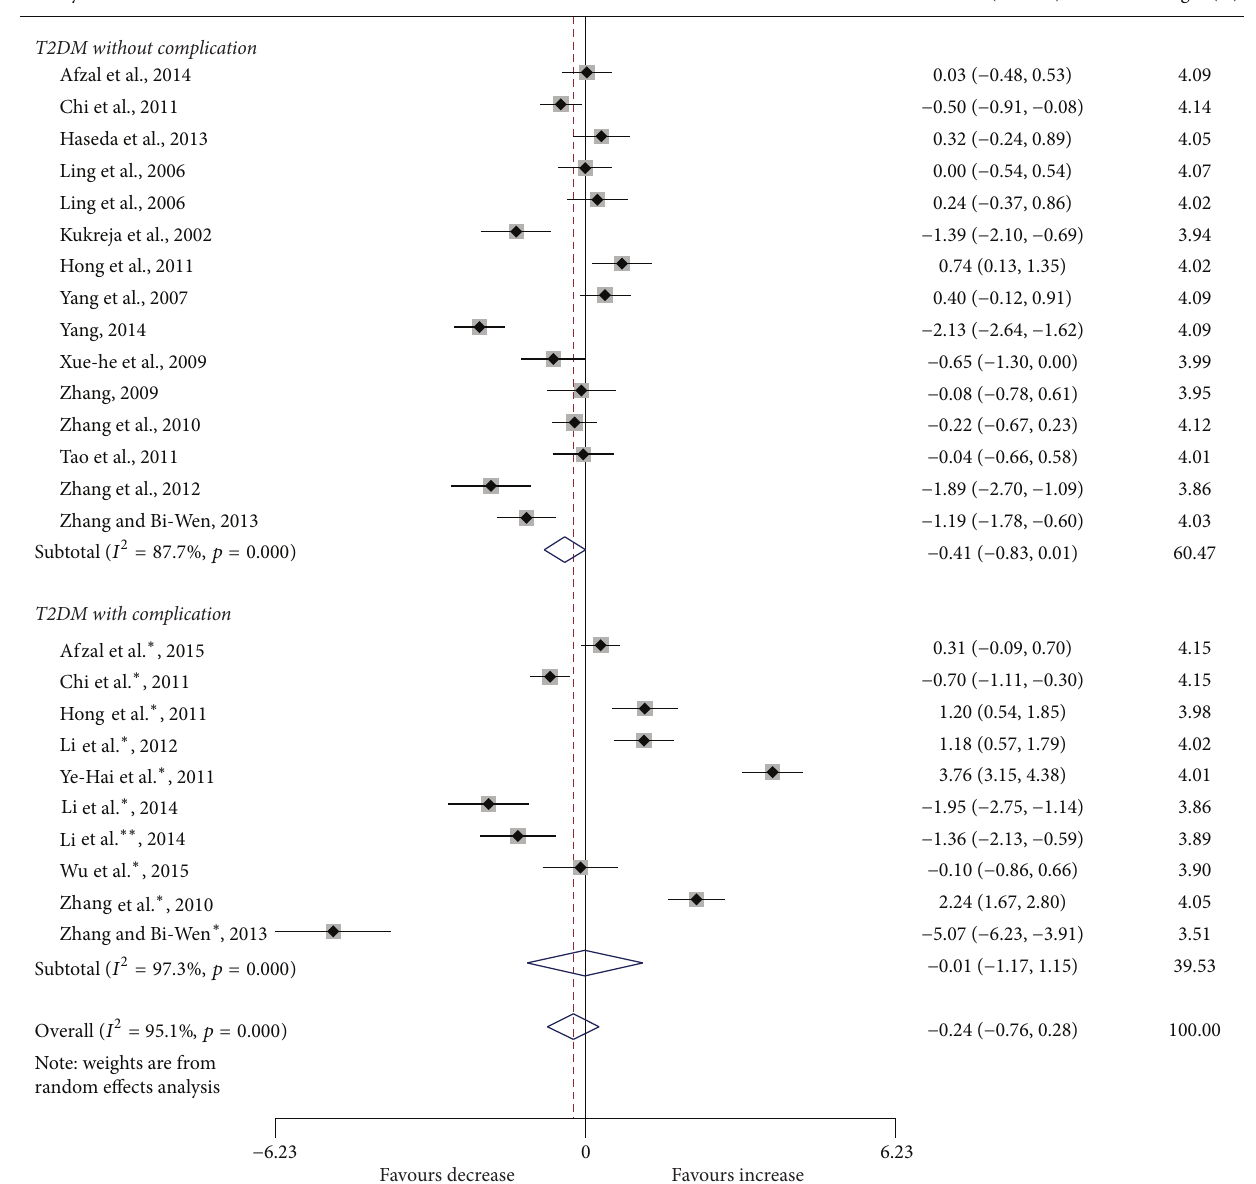
Figure 7: Forest plots for the frequency of CD4 + CD25 + Treg in T2DM patients and controls with random effects model (T2DM without complication, 𝑝 = 0.053 ; T2DM with complication, 𝑝 = 0.987 ; overall, 𝑝 = 0.360 ). ∗ T 2 DM with complication. ∗∗ T 2 DM with different